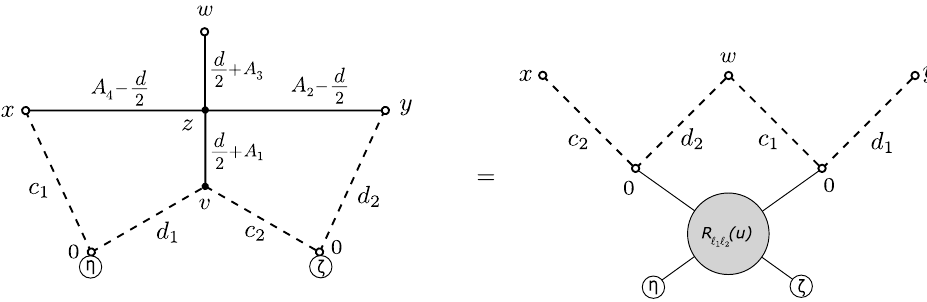
( u ) , as encoded 1 ,l 2